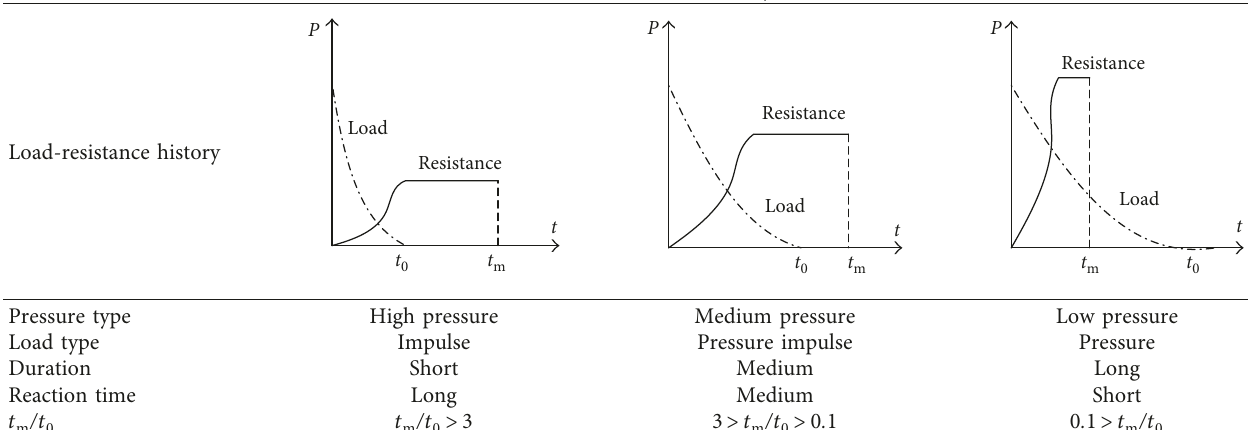
Table 4: Load-resistance history.